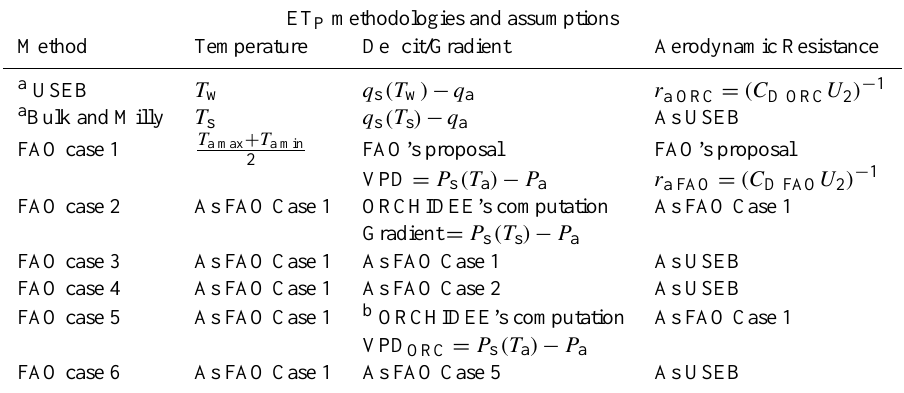
Table 2. Description of ET P USEB , ET P BULK , ET P Milly and the cases defined to compute ET P FAO , according to the variables they depend on and the assumptions made for their calculation. The computation has been carried out at a daily time step, except for the following cases: a The time step computation of ET P has been the LSM’s one, 30min. A daily mean has been computed afterwards. b The parameter’s time step computation has been the LSM’s one, 30min. Next a daily mean has been saved to use it in FAO’s